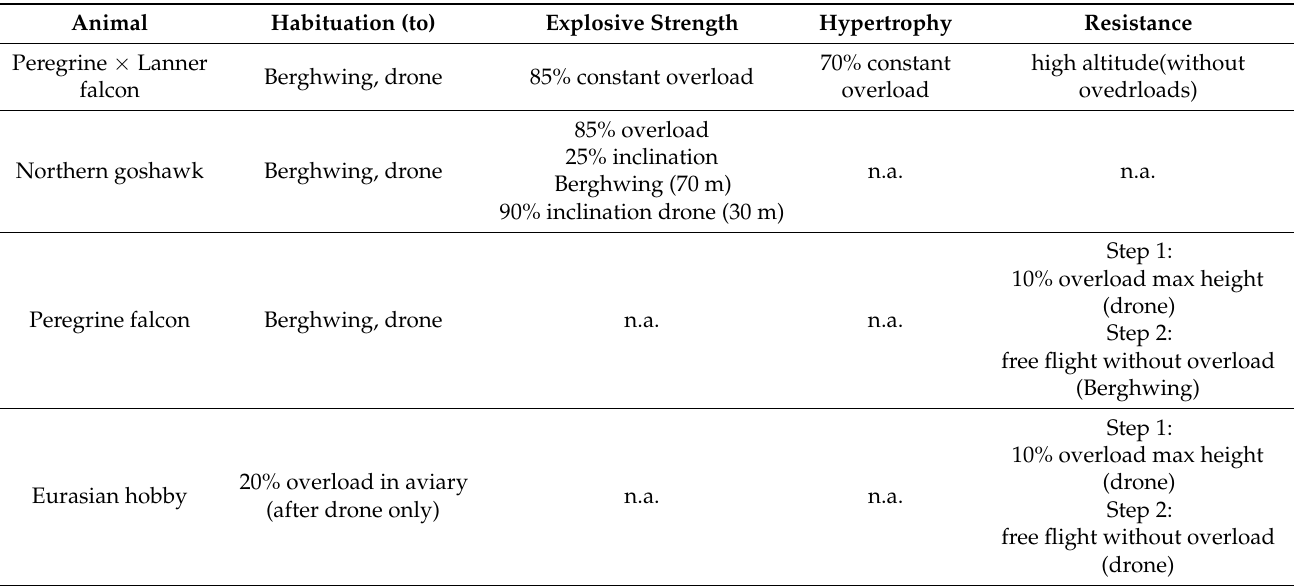
Table 3. The table shows the different raptors and the according workouts individually chosen for their training. Legend: n.a. = not